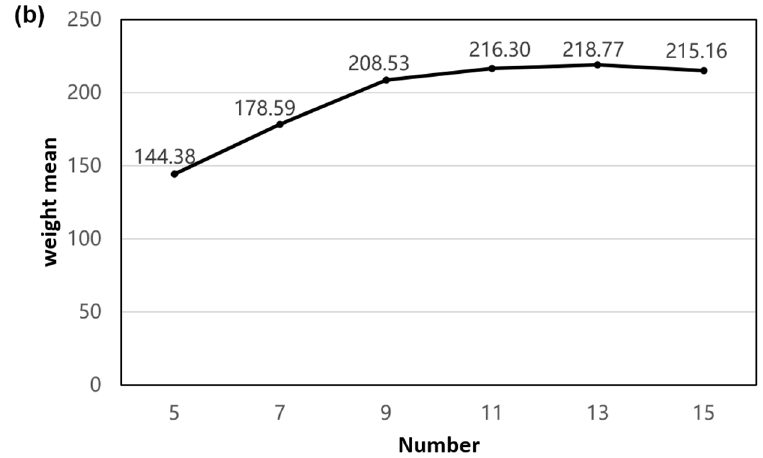
Figure 8. Curve plot of the classification number and weight mean: ( a ) result of commercial- intersection KDE and ( b ) result of planar KDE.